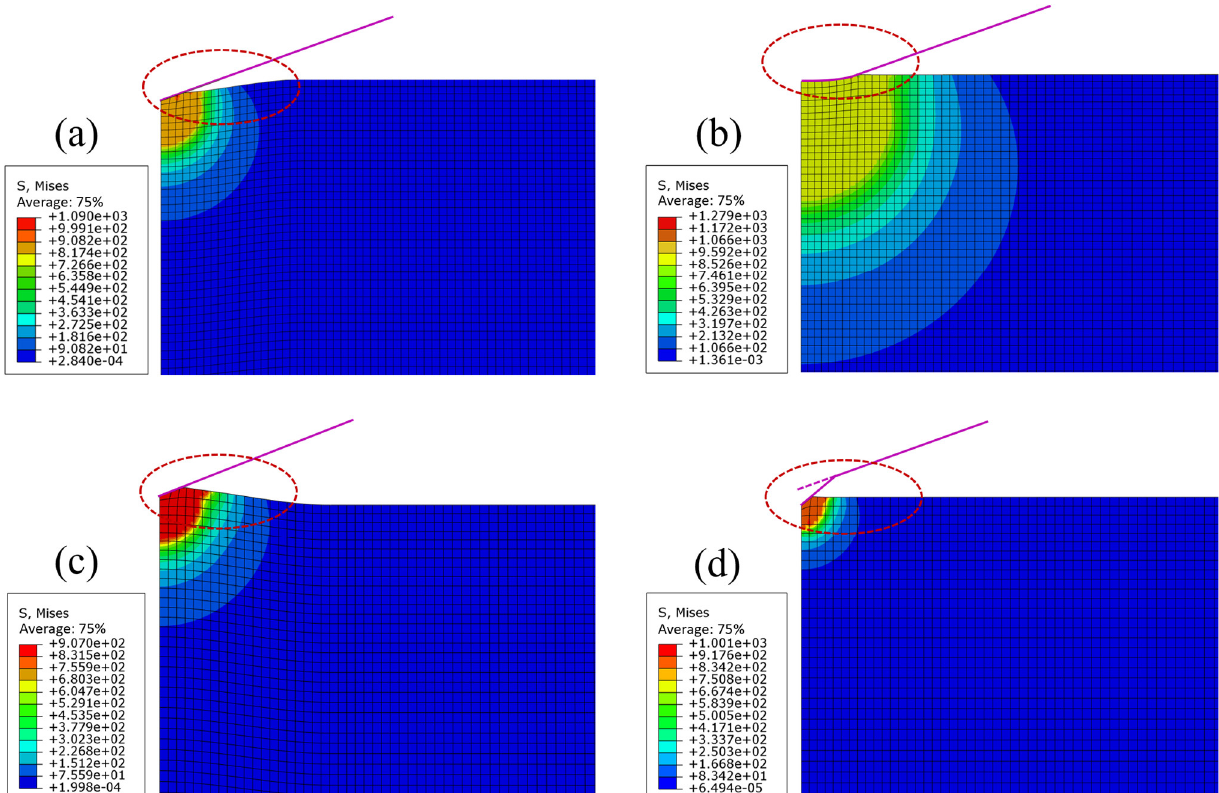
Figure 12. Stress distribution of simulation process: ( a ) groove defect; ( b ) tip bluntness; ( c ) convex defect; ( d ) tip sharpness.